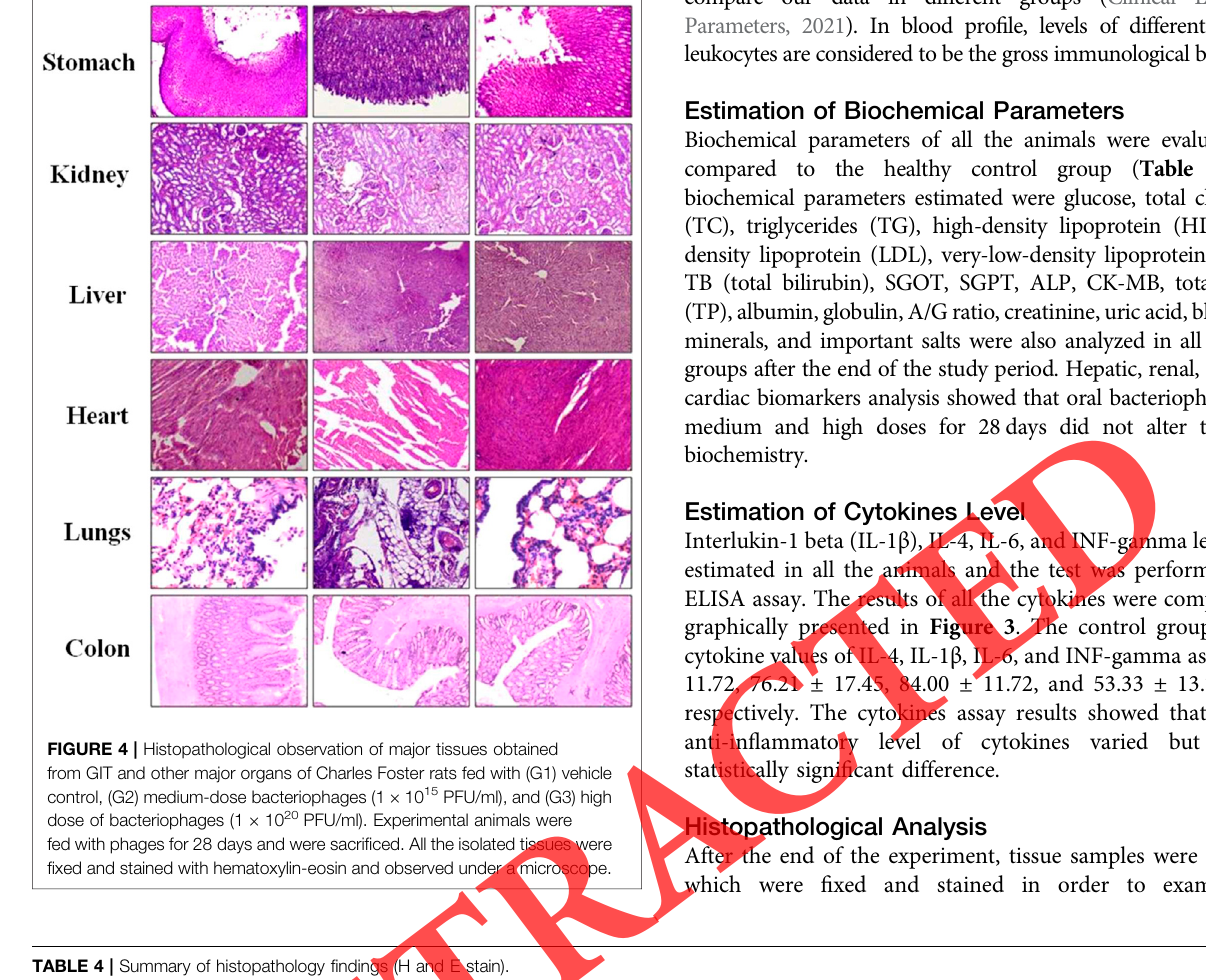
TABLE 4 | Summary of histopathology fi ndings (H and E